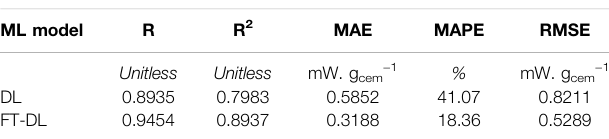
TABLE 2 | Statistical parameters describing the mean prediction errors (i.e., averaged over a period of 24 h) of DL and FT-DL models. Errors were estimated by comparing predicted heat fl ow rate pro fi les of (PC + SCM) pastes against experimentally-measured ones. Time-solved prediction errors are descried in Supplemetary Information